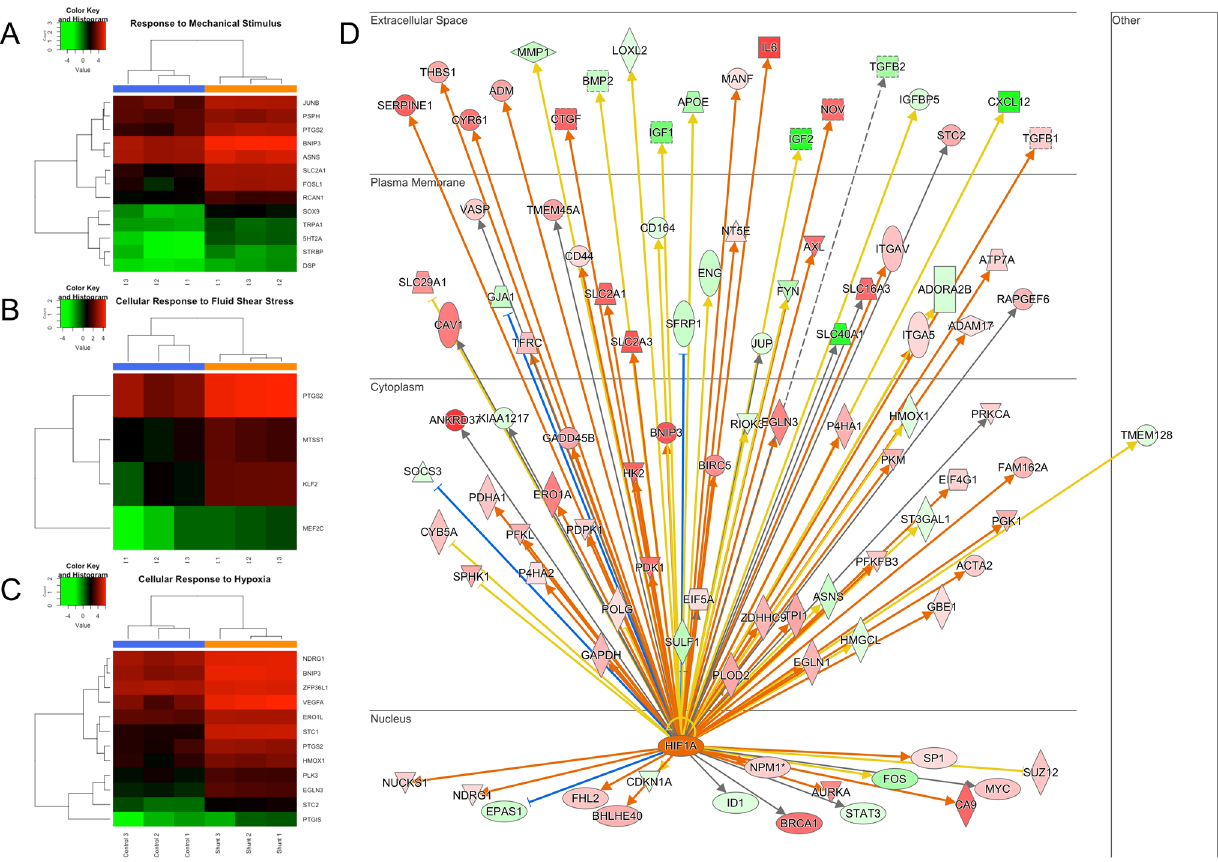
Figure 2. RNA-sequencing analysis. Supervised clustering heat maps demonstrate that upregulated DEGs mapped to processes activated in ( A ) the response to mechanical stimulus, ( B ) the cellular response to fluid shear stress, and ( C ) the cellular response to hypoxia. ( D ) DEGs targeted by HIF-1α in shunt LECs, as predicted by Ingenuity Pathway Analysis upstream regulator modeling. N = 3 control, 3